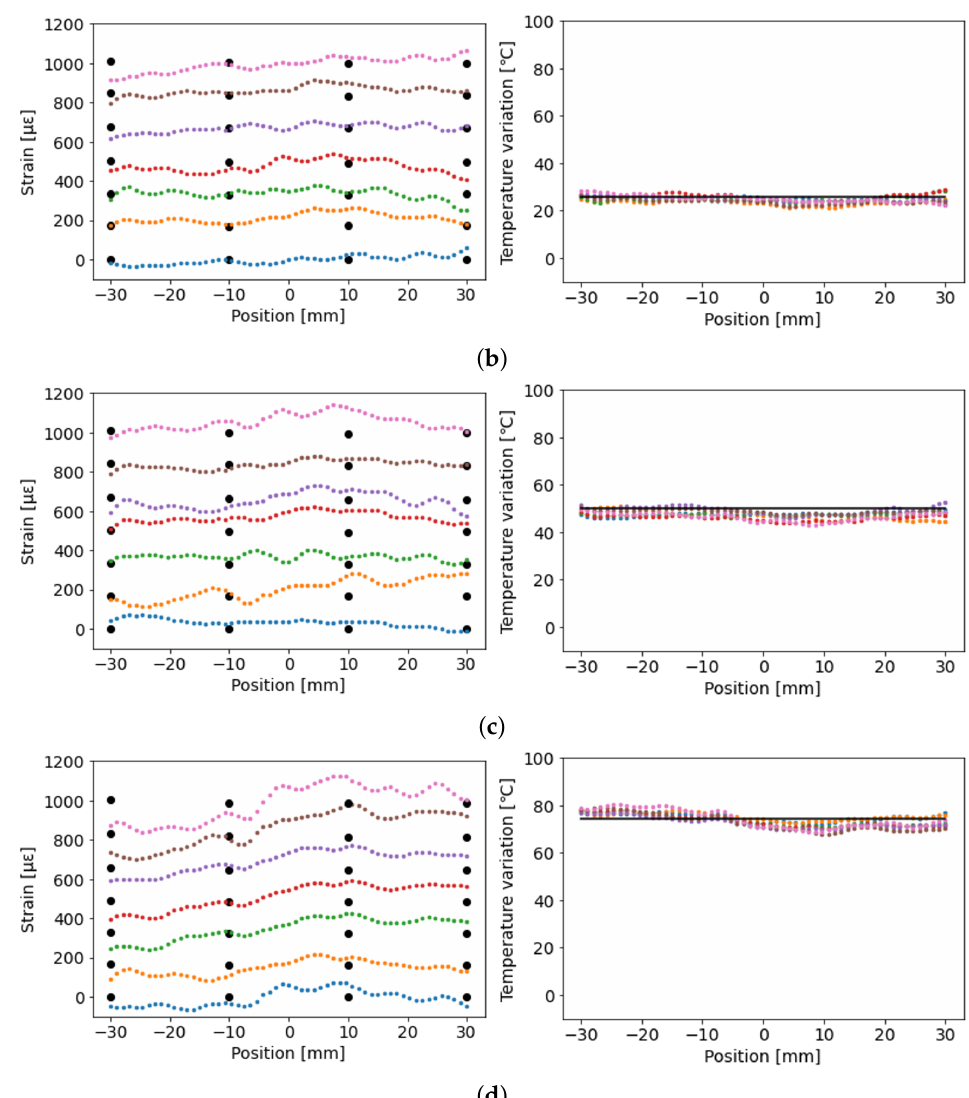
Figure 8. Strain and temperature distributions measured by combining F1, F2, and F4: ( a ) 25 °C case ( ∆ T = 0); ( b ) 50 °C case ( ∆ T = 25); ( c ) 75 °C case ( ∆ T = 50); ( d ) 100 °C case ( ∆ T =